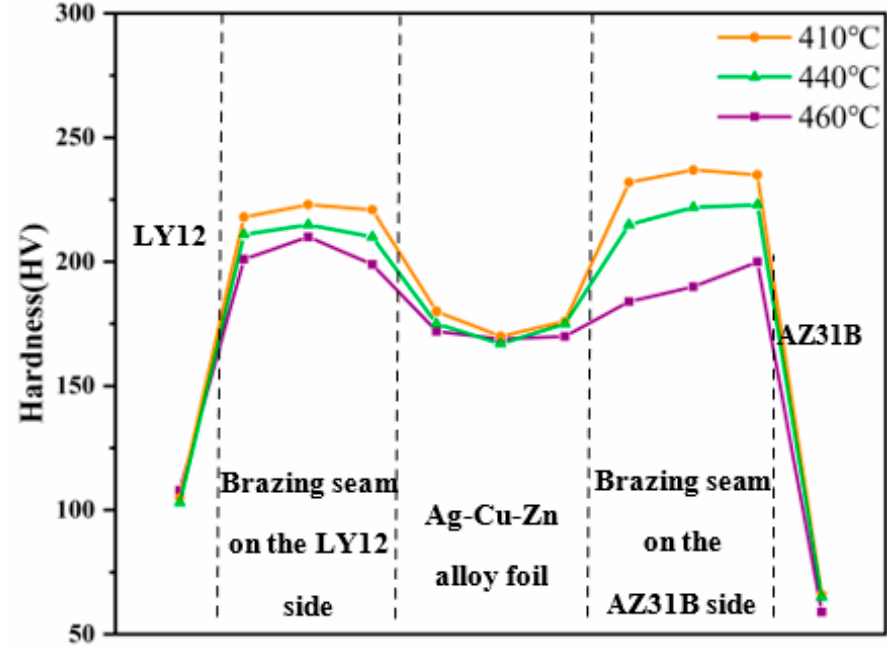
Figure 7. Hardness in different areas of the joint at 410 °C, 10 s; 440 °C, 10 s; and 460 °C, 10 s.